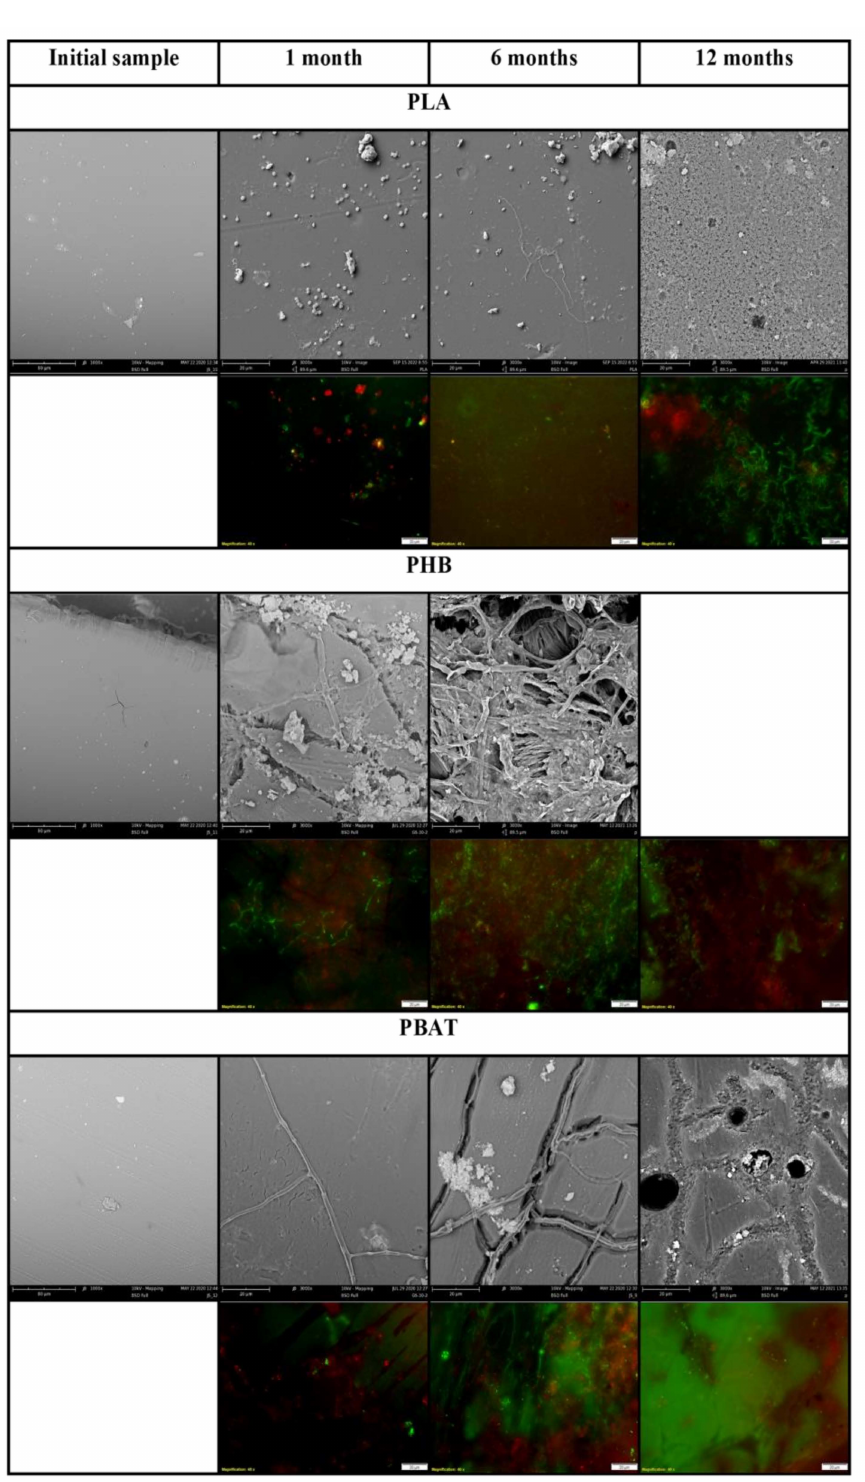
Figure 3. Scanning electron micrographs and live/dead photos of polyesters. Magnification of initial SEM samples 1000 × , incubated SEM samples 3000 × , fluorescent microscopy samples 400 ×